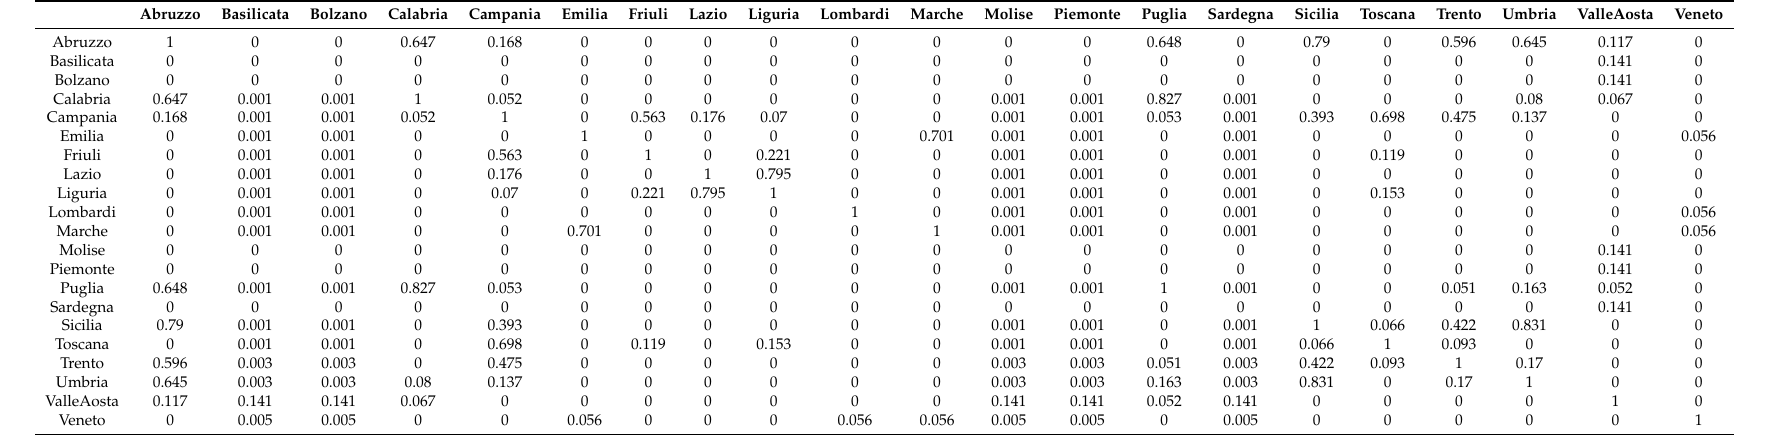
Table A40. Similarity values of Discharged/Healed network in the third